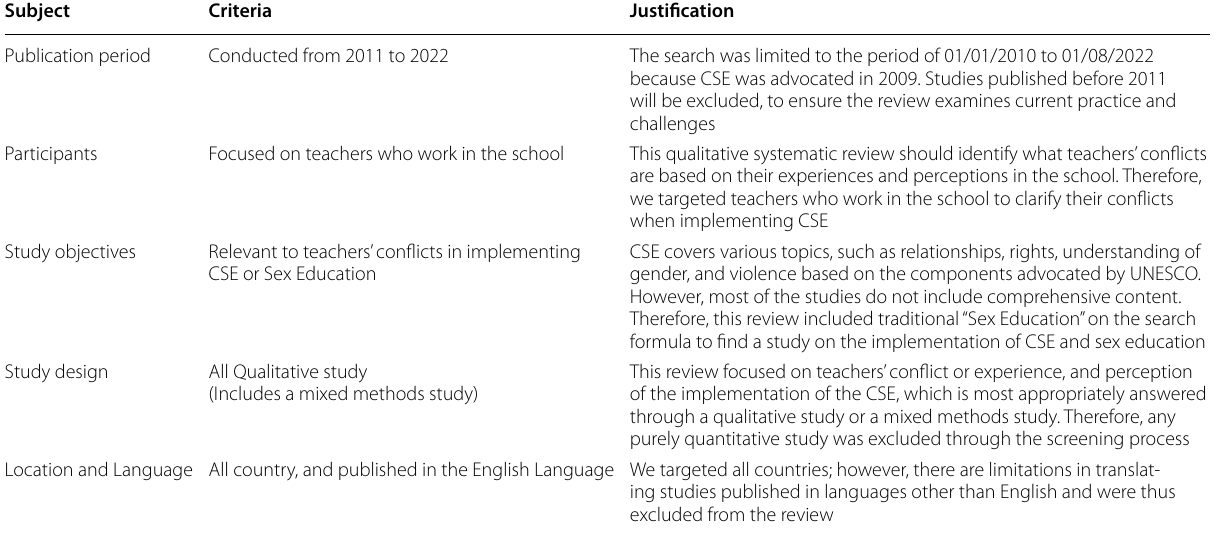
Table 2 Summary of the inclusion